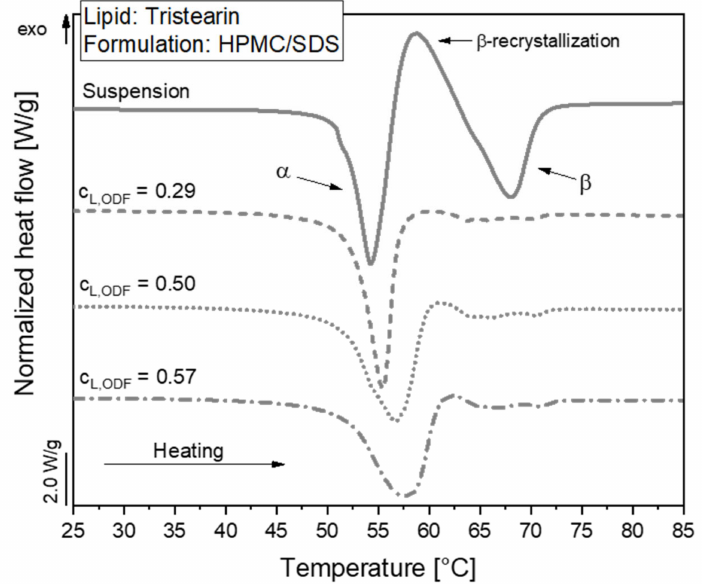
Figure 4. DSC melting curves of lipid nanoparticles stabilized with HPMC/SDS as suspension (lipid content 0.1) and embedded in ODFs with different lipid contents (c L,ODF ) measured one day after film preparation. To facilitate visual comparison of the curves, the heat flows were normalized to the sample mass and the lipid concentration of the respective